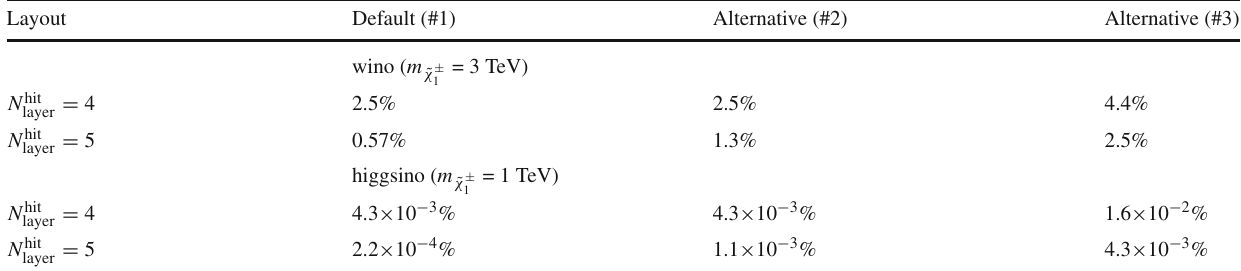
Table 2 Signal acceptance for the 3 TeV wino and 1 TeV higgsino with out #3 has significantly higher acceptance than the others because the | η | < 1forthethreeinner-trackerlayouts.Theacceptancesareprovided relevant layers are located closer to the beam line, particularly for the = 4 and 5. The alternative lay- separately for the requirements of N hit layer